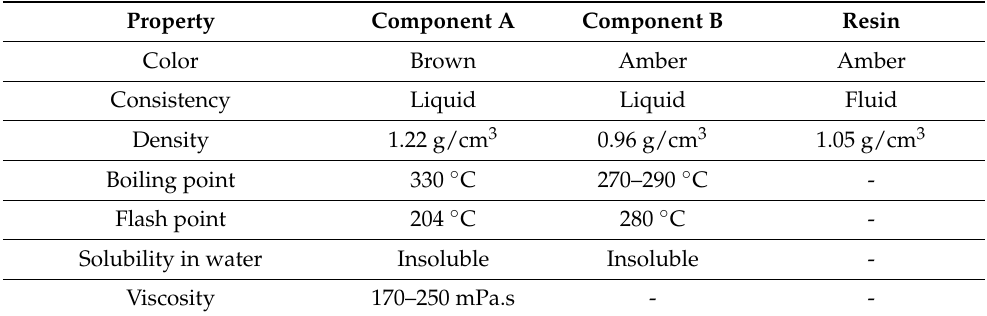
Table 1. Physical and chemical properties of individual components and the two-component polyurethane